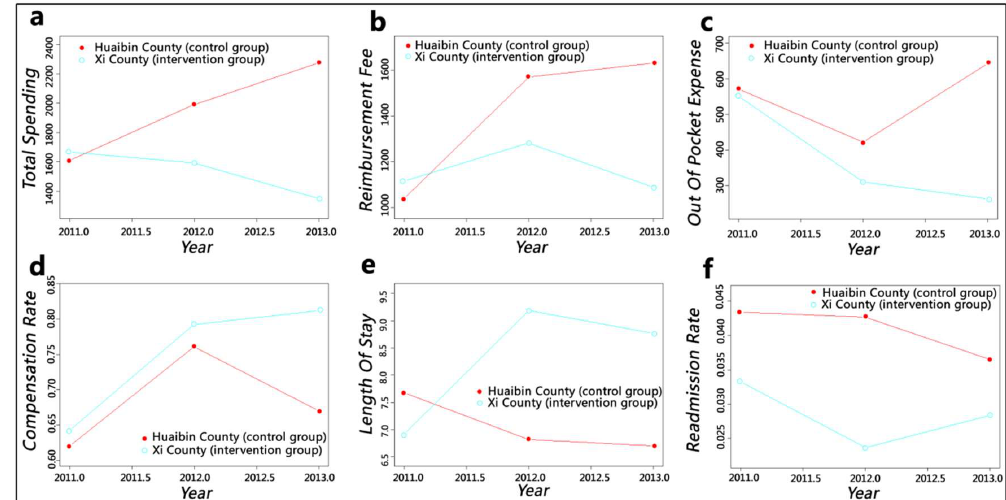
Figure 4. Smooth curves fitting for the township health centre level: ( a ) adjusted mean of total spending; ( b ) adjusted mean of reimbursement fee; ( c ) adjusted mean of out-of-pocket expense; ( d ) adjusted mean of compensation ratio; ( e ) adjusted mean of length of stay; ( f ) adjusted mean of readmission rate.